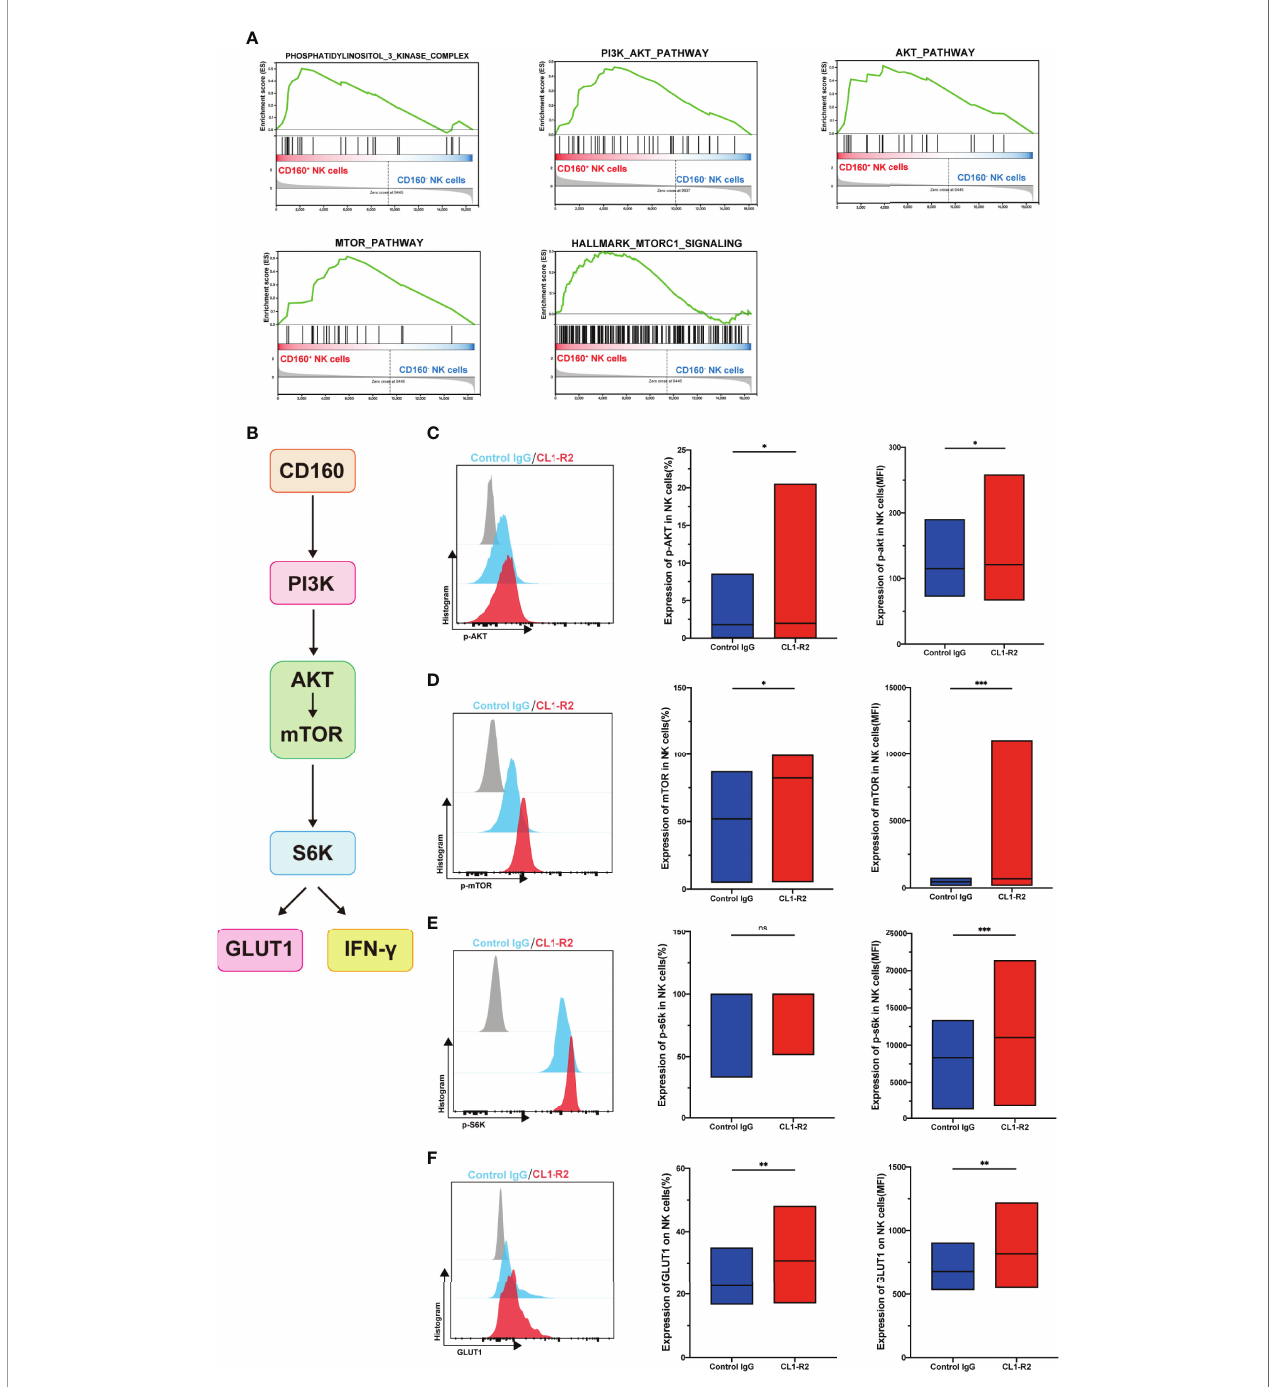
FIGURE 5 | CD160 upregulates NK-cell glucose metabolism through AKT/mTOR/s6k signaling pathway. (A) GSEA analysis of RNA-seq data from CD160 - or CD160 + NK cells. (B) Schematic showing the hypothetical signaling pathway triggered by CD160 to regulate NK cell function. (C – E) NK cells from HIV-infected individuals were treated with 10 μg/ml CL1-R2 antibody or negative control IgG1 for 30min, then AKT (C) , mTOR (D) , and s6k (E) phosphorylation in total NK cells from HIV-infected individuals were measured by fl ow cytometry. Representative histogram (left), percentage (middle), and mean fl uorescence intensity (right) (n= 28). (F) Treated with 10 μg/ml CL1-R2 antibody or negative control IgG1 for 1h, and then stimulated with IL-12 + IL-15 + IL-18 (10, 50 and 100 ng/ml, respectively) for 24h, the expression of GLUT1 on total NK cells from HIV-infected individuals were analyzed (n=11). The mean fl uorescence intensity of p-AKT, p-mtOR, p-s6k, and GLUT1 in (C – F) was from total NK cells. A Wilcoxon matched-pairs signed-rank test was employed for paired-group comparisons; * P < 0.05; ** P < 0.01; *** P < 0.001; ns, no signi fi cance. Data are represented as means ±